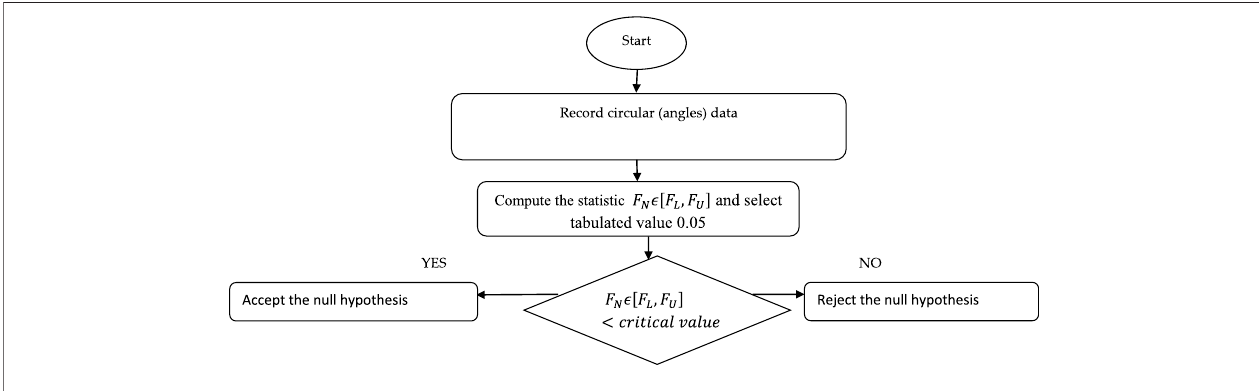
FIGURE 1 | The procedure of the proposed N-W-W